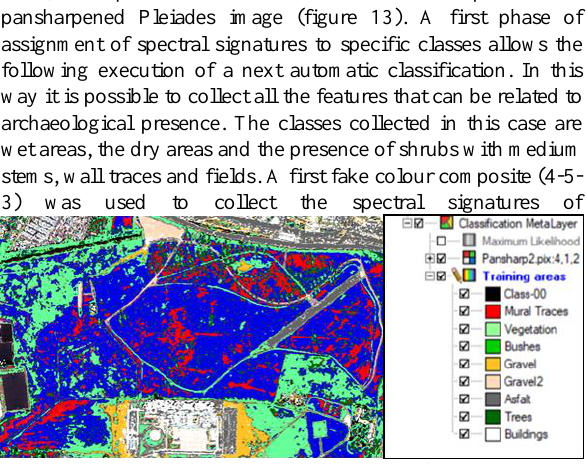
supervised classification of the Pleiades Pansharpened image